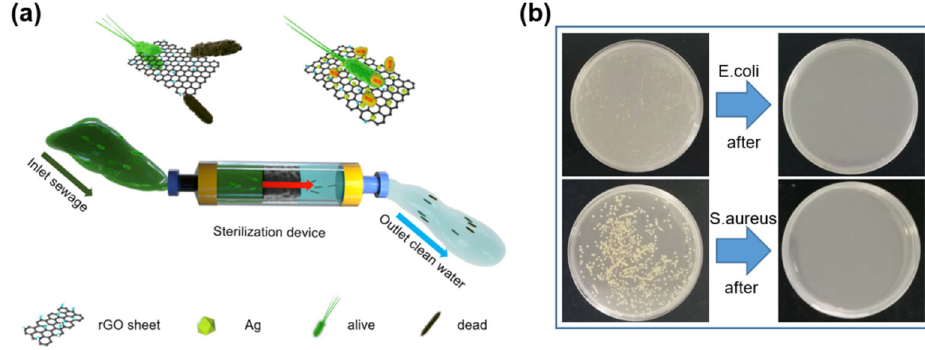
Figure 5. ( a ) Schematic diagram of water filtration setup. ( b ) Column disinfection performance.